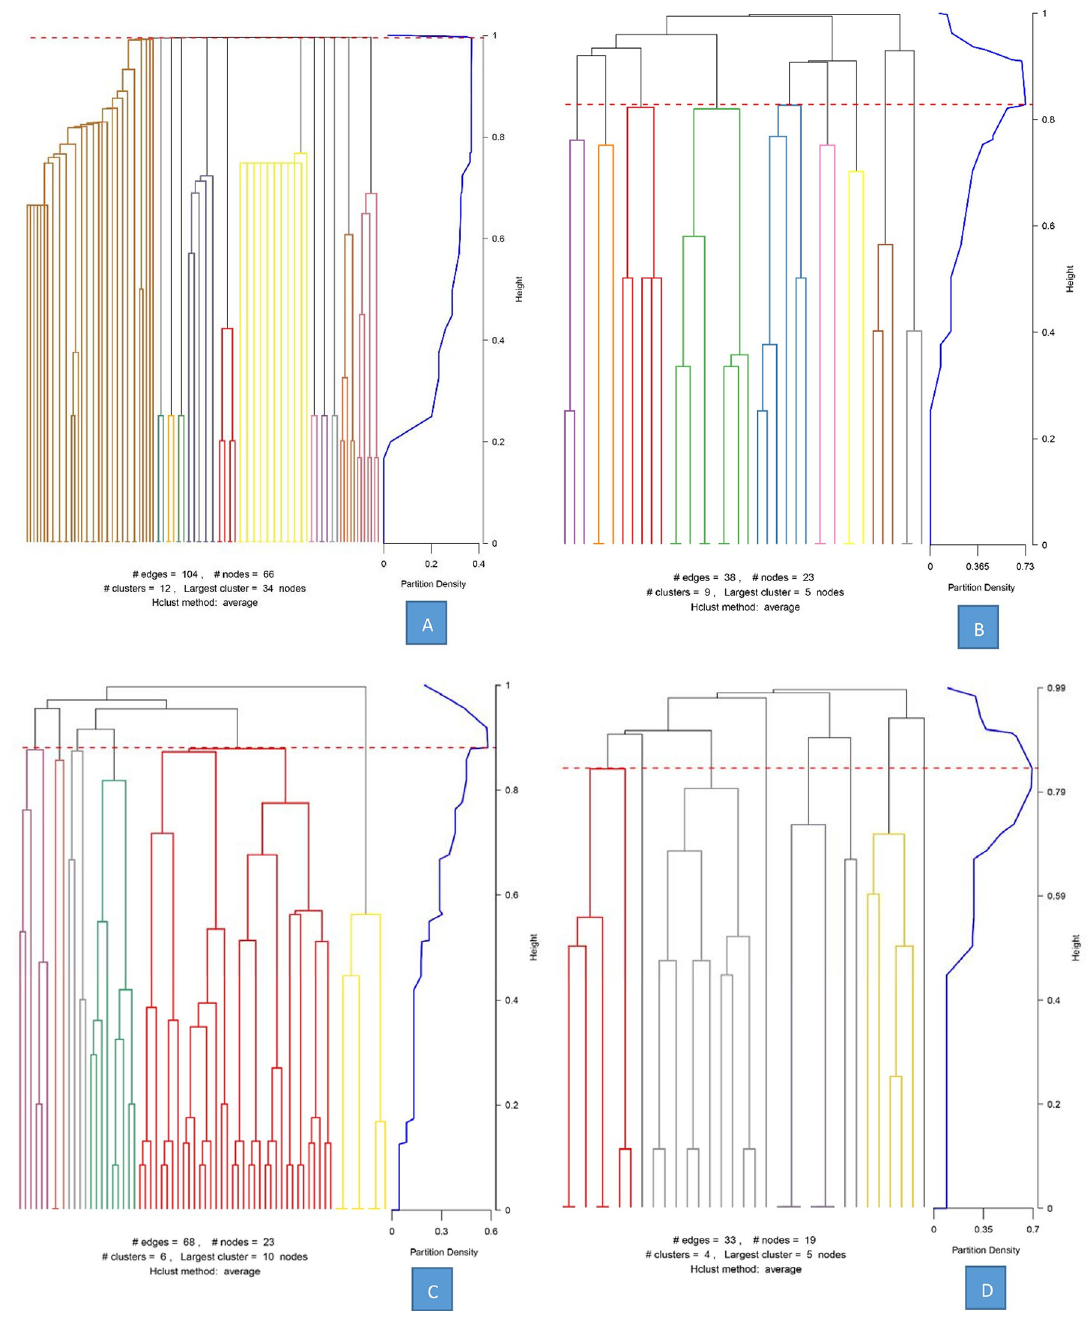
Fig 4. The dendrogram of link clustering for the clusters. (A) The dendrogram of cluster 1. (B) The dendrogram of cluster 2. (C) The dendrogram of cluster 3. (D) The dendrogram of cluster